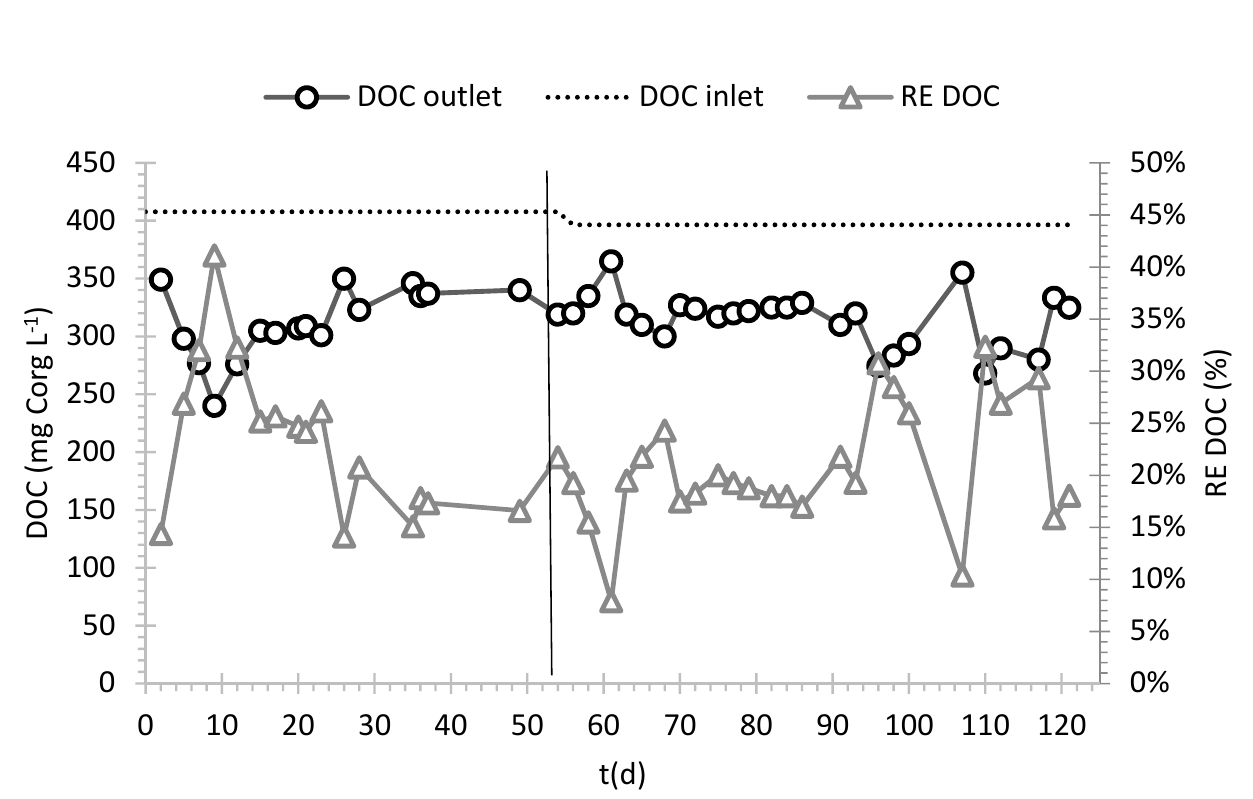
Figure 2. Inlet and outlet COD concentrations and COD removal percentages during continuous treatment in the pilot reactor. Different phases of the experiment are divided by vertical line.